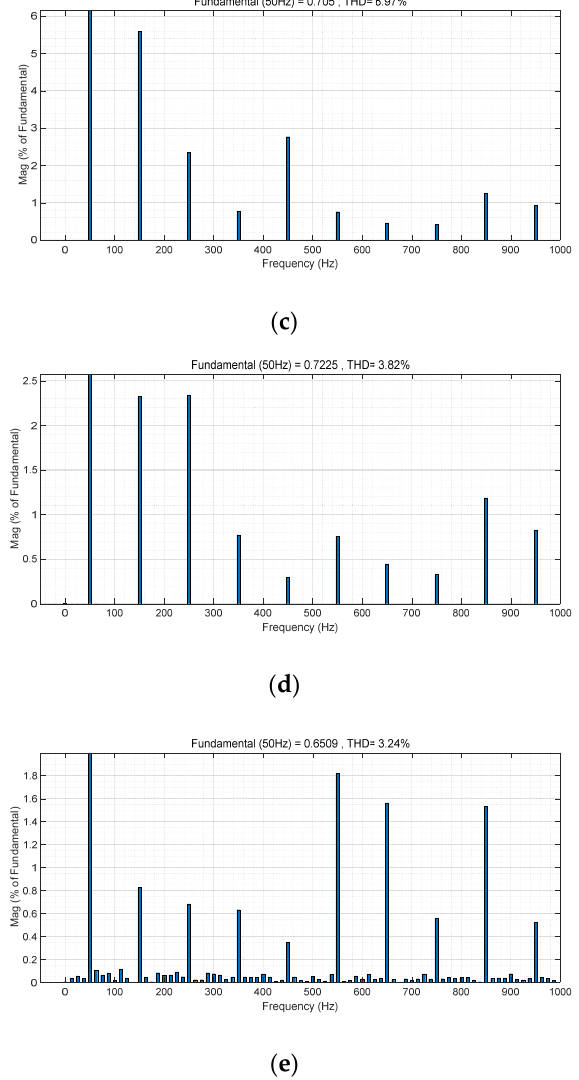
Figure 13. The current distortion rate of the transformer’s grid-side winding under different operating scenarios. ( a ) The distortion rate of transformer’s grid-side winding current without any filtering device. ( b ) The distortion rate of transformer’s grid-side winding current without any filtering device considering the 5th and 7th fully tuned branches. ( c ) The distortion rate of transformer’s grid-side winding current considering the 5th, 7th, 11th, and 13th fully tuned branches. ( d ) The distortion rate of transformer’s grid-side winding current considering the 5th, 7th, 11th, 13th, 3rd, and 9th fully tuned branches. ( e ) The distortion rate of the transformer’s grid-side winding current under the proposed HIAF system.